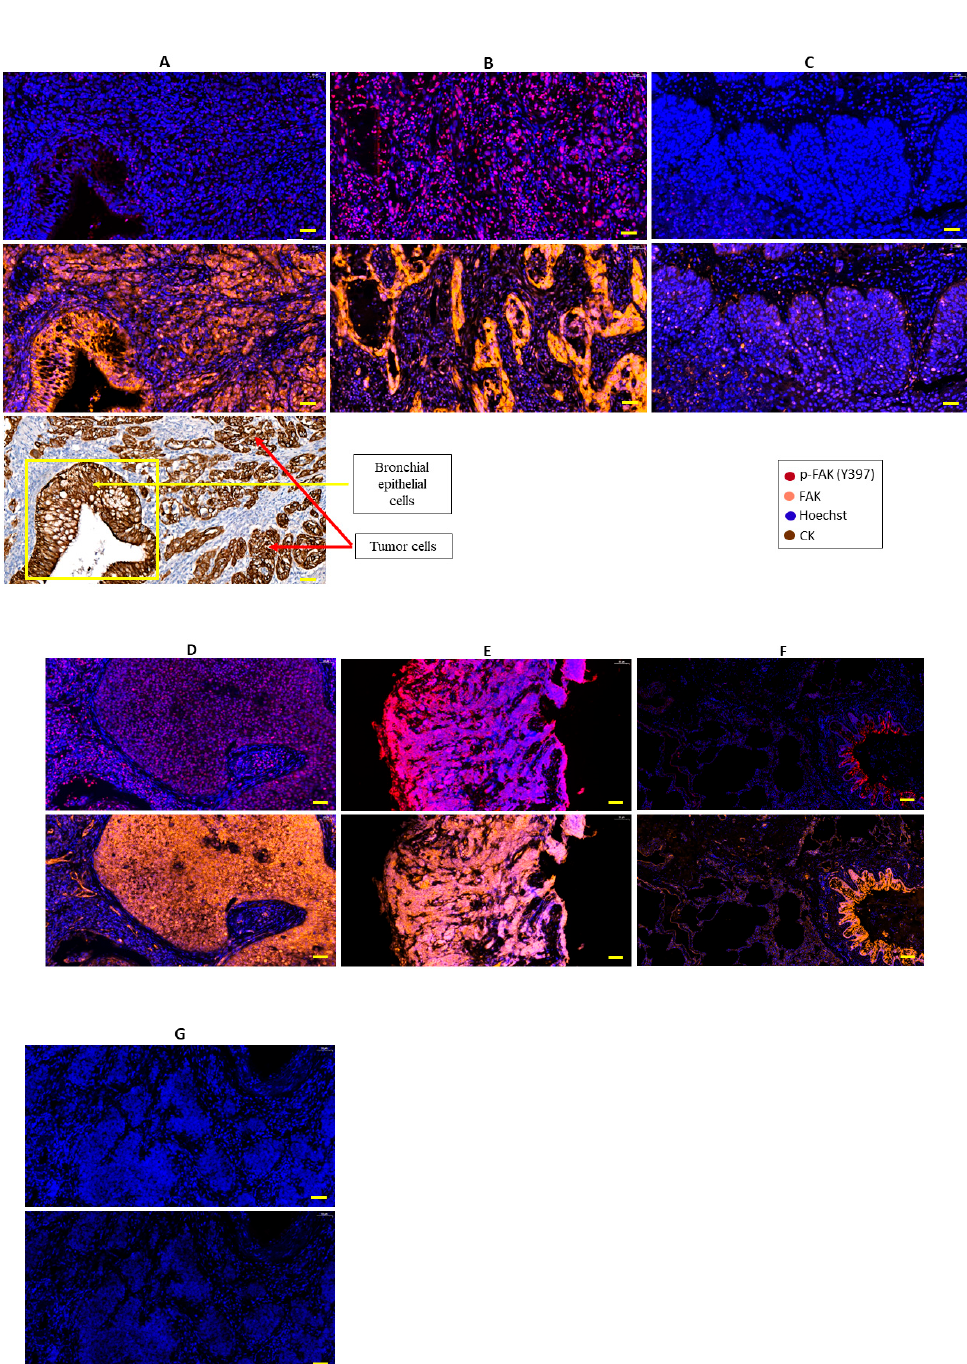
Figure 2. Illustrations of FAK and phospho-FAK (Y397) expression evaluated by multiplex immunofluorescence (IF) immunohistochemistry (IHC) in lung cancer and normal lung tissues. ( A ) Lung adenocarcinoma with the absence of phospho-FAK expression but homogenous cytoplasmic FAK staining (orange) in the tumor core, adjacent non-tumoral bronchi, and some stromal cells (including vessels and lymphoid structures). ( B ) Lung adenocarcinoma with nuclear phospho-FAK staining (red) and homogenous cytoplasmic FAK staining (orange). ( C ) Lung squamous carcinoma with the absence of phospho-FAK expression but weak cytoplasmic FAK staining. ( D ) Lung squamous carcinoma with nuclear phospho-FAK staining (red) and homogenous cytoplasmic FAK staining (orange). ( E ) Small-cell lung cancer with nuclear phospho-FAK staining (red) and cytoplasmic FAK staining (orange). ( F ) Normal lung with cytoplasmic FAK staining in bronchi and some stromal cells (including vessels and lymphoid structures). ( G ) Lung squamous carcinoma used as a negative control, showing the absence of phospho-FAK and FAK staining. Original magnification: 20 × ; scale bar: 50 µ